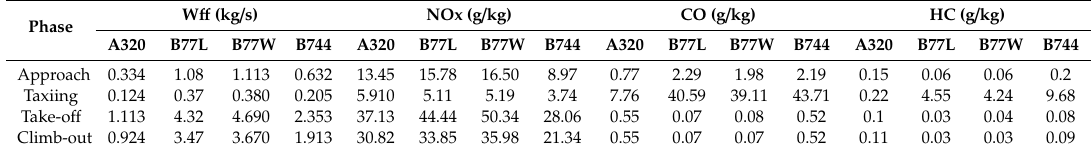
Table 6. Comparison of the fuel flow rates and the EIs of NOx, CO, and HC for A320, B77L, B77W, and B744.